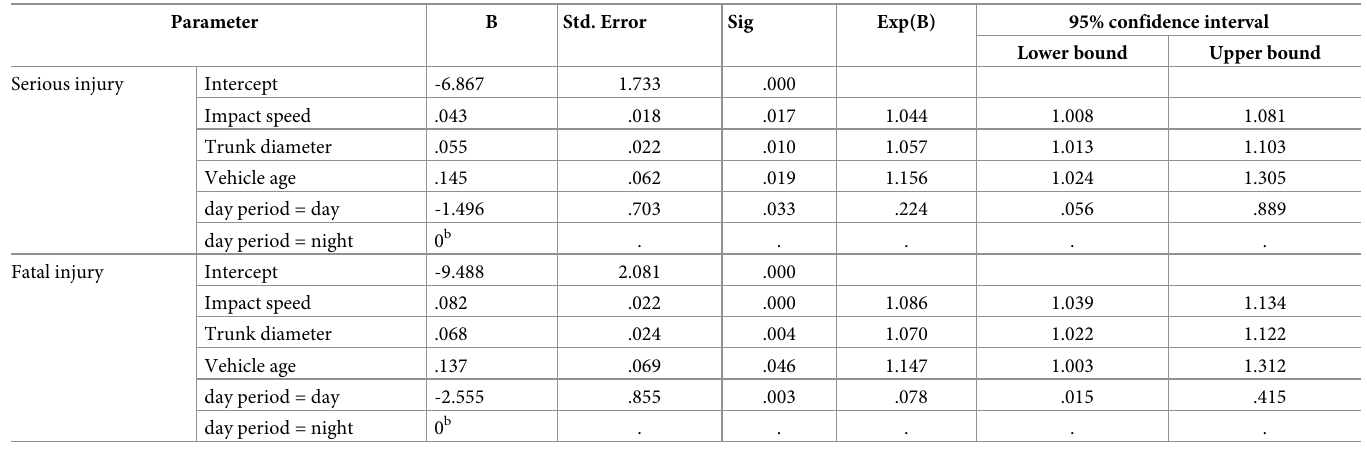
Table 5. Parameter